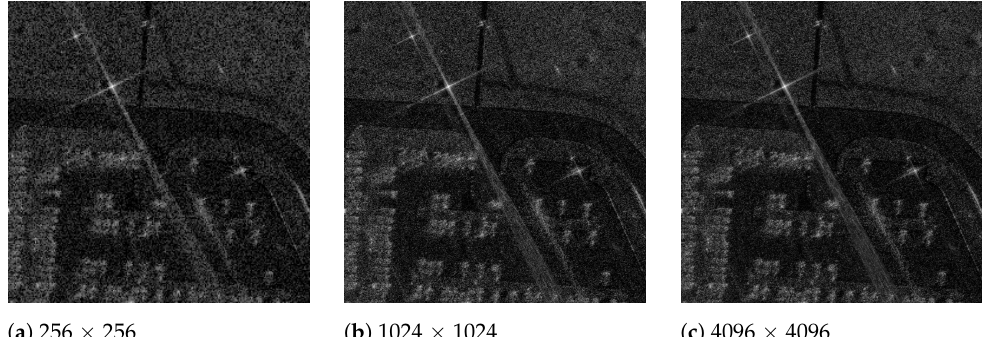
Figure 11. BP-VISAR frames of different frame resolutions (sub-aperture processing in overlapped mode, frame 29, α = 0.8).